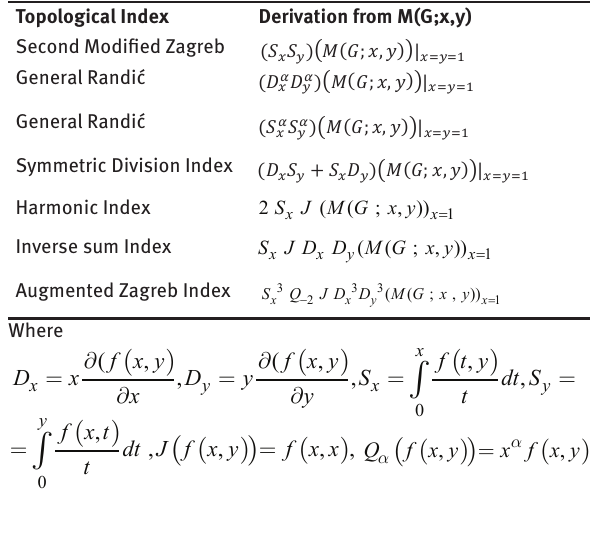
Table 1: Derivation of some degree-based topological indices from M-polynomial. Topological Index